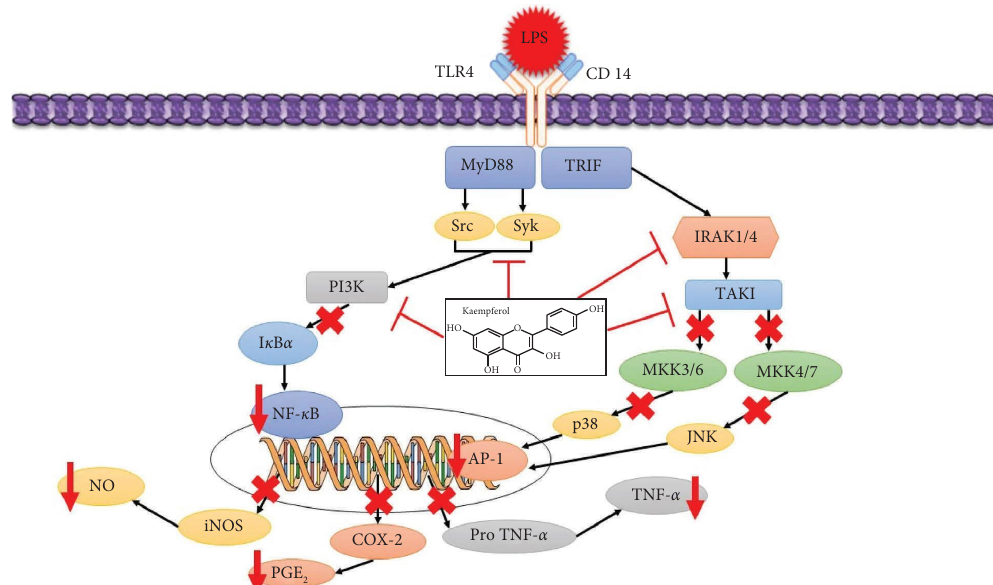
Figure 6: A proposed schematic diagram illustrating the mechanism of protection of kaempferol against LPS-induced acute liver injury. Inhibition ( ⟞ ), red arrows (suppression).